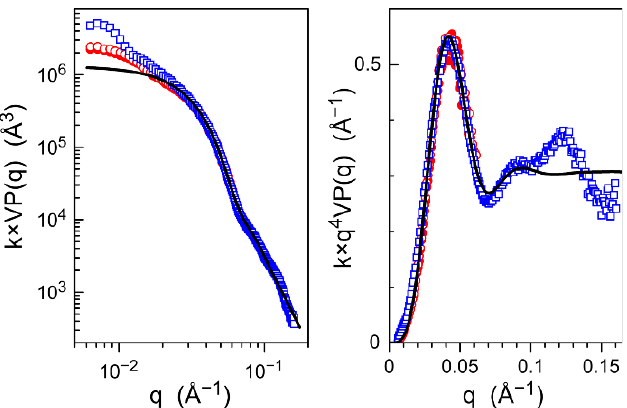
Figure 7. Form factor variation determined by SAXS as a function of the scattering vector ( left ) and Porod representation ( right ) of the following solutions of hybrid objects in THF: PS/γ -Fe 2 O 3 , initial volume fraction ϕ v,ini = 0.01 (red solid circles, curve stops at 0.06 Å −1 ); PS/γ -Fe 2 O 3 , ϕ v,ini = 0.02 (red open circles, curve stops at 0.06 Å −1 ); PMMA/γ -Fe 2 O 3 , ϕ v,ini = 0.01 (blue solid squares); PMMA/γ - Fe 2 O 3 , ϕ v,ini = 0.02 (blue open squares); the black line is the fit for a Gaussian distribution of balls, with 13 nm mean diameter and 6 nm standard deviation.